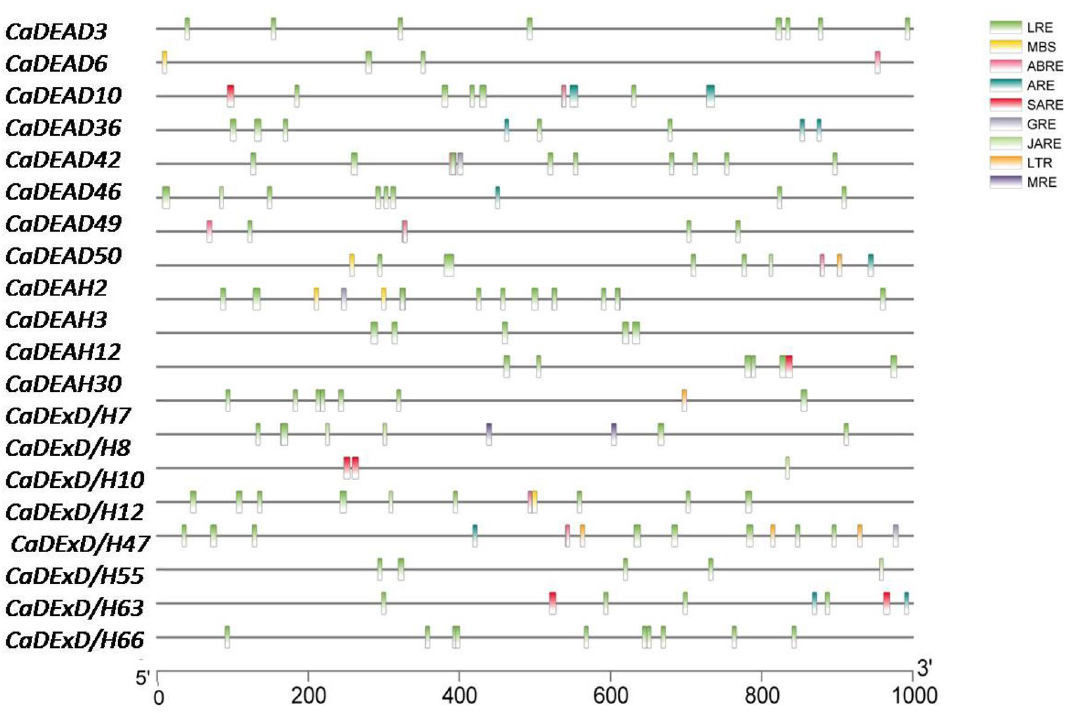
Figure 4. The cis-acting elements in the promoter regions of selected RNA helicase genes (8 CaDEAD + 4 CaDEAH + 8 CaDExD/H- box) genes in chickpea. The scale at the bottom represents 1000 bp upstream from the TSS for the genes. The elements identified are abbreviated as LRE light responsive-element, MBS MYB binding site involved in drought-inducibility, ABRE element involved in the abscisic acid responsiveness, ARE part of an auxin-responsive element, SARE element involved in salicylic acid responsiveness, GRE gibberellin-responsive element, JARE element involved in the methyl jasmonate or MeJA responsiveness, LTR element involved in low- temperature responsiveness and MRE MYB binding site involved in light